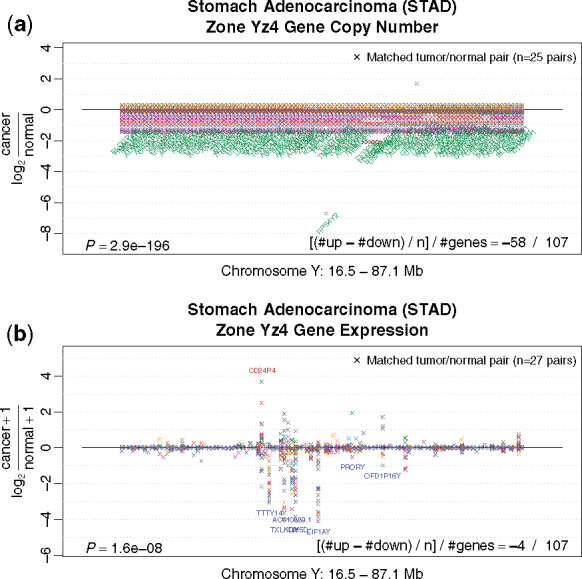
The top polarized zone in somatic copy number alteration in stomach adenocarcinoma (STAD). (a) Log ratios of SCNA of all genes in STAD tumor over matched normal stomach tissue in the most significantly polarized SCNA zone in STAD. (b) Log ratios of gene expression in STAD tumor over matched normal stomach tissue of the same zone. Genes are ordered by genomic coordinate but equal-space positioned